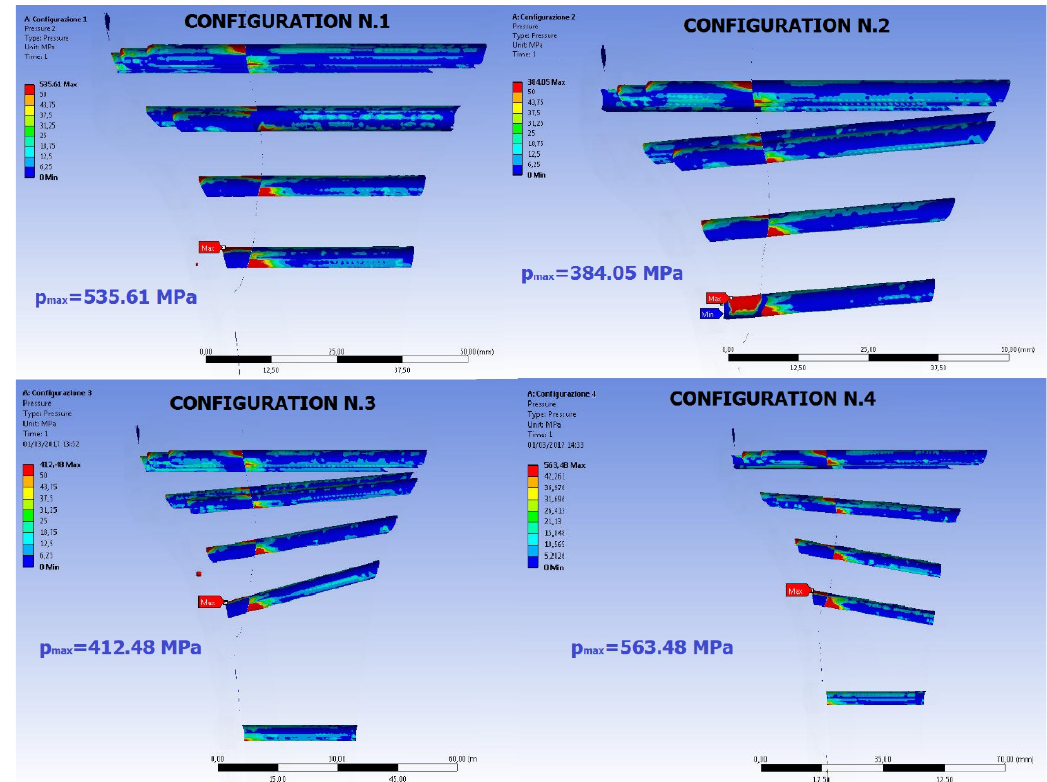
Figure 11. FEM analysis results: pressure maps at the screw/tibia interfaces.